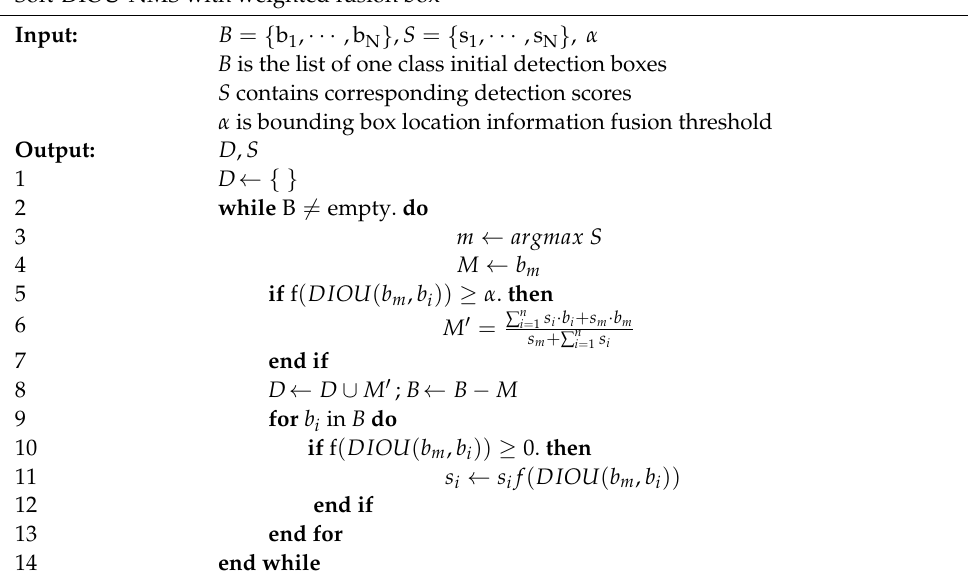
Algorithm 1 Pseudocode of Soft-DIOU-NMS with weighted fusion box. Soft-DIOU-NMS with weighted fusion